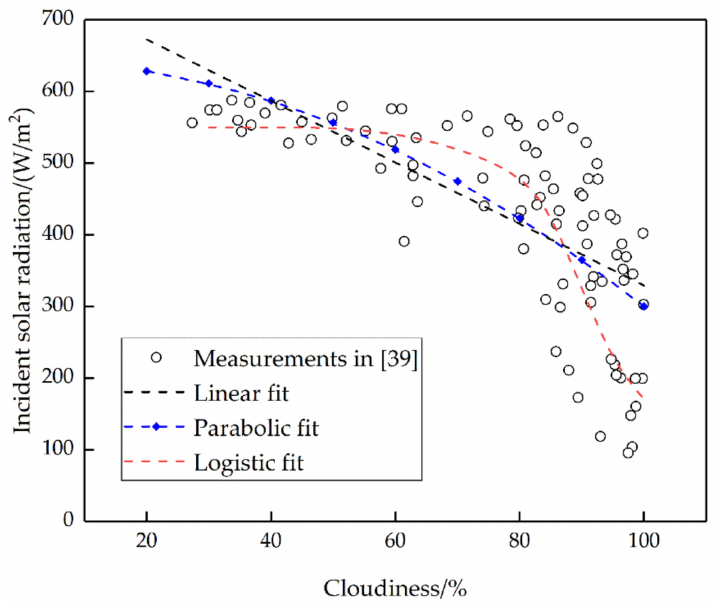
Figure 7. Correlation between cloud cover and solar radiation (circle), and the linear fit line (black) in [39]. Also shown are the parabolic fit (blue) and logistic lines (red) for